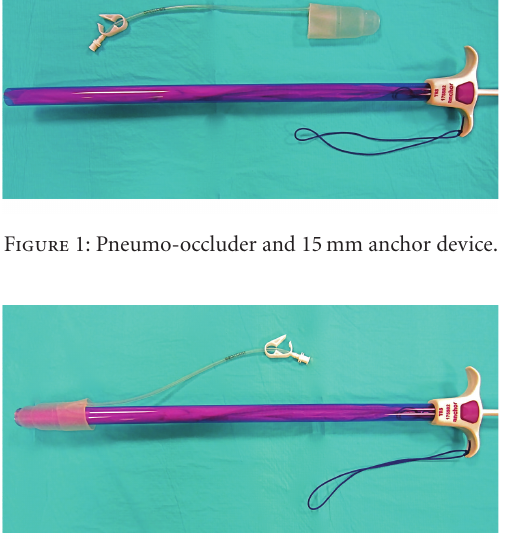
Figure 2: Pneumo-occluder placed onto tip of device.